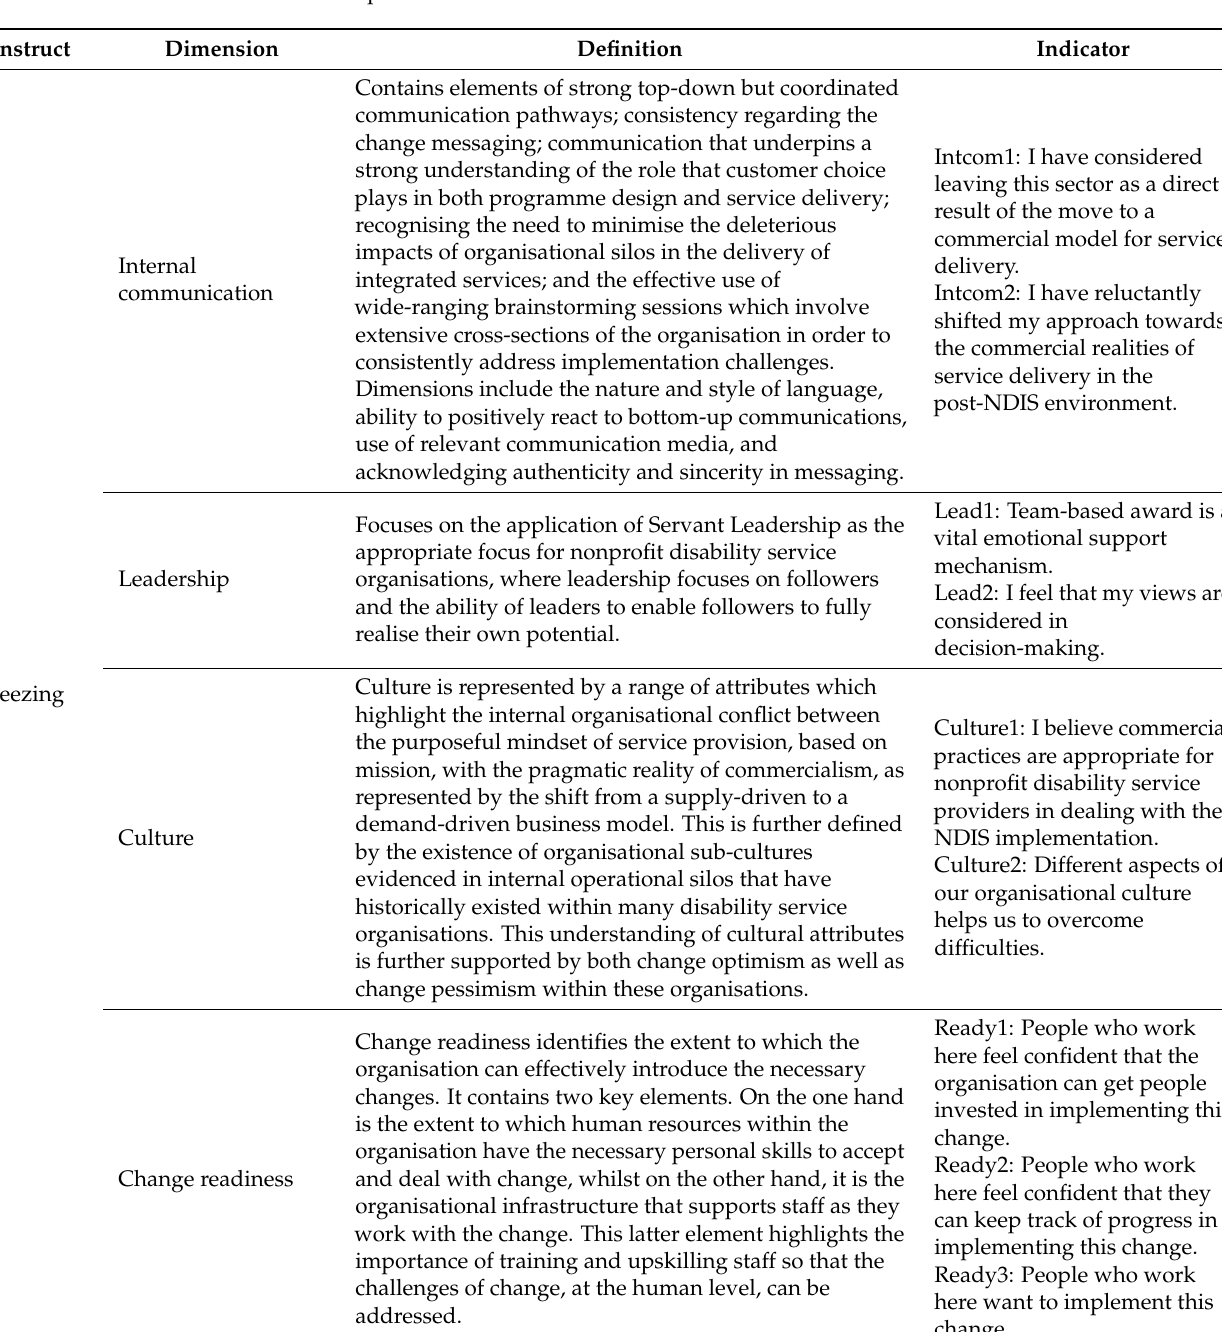
Table 2. Operational indicators of latent